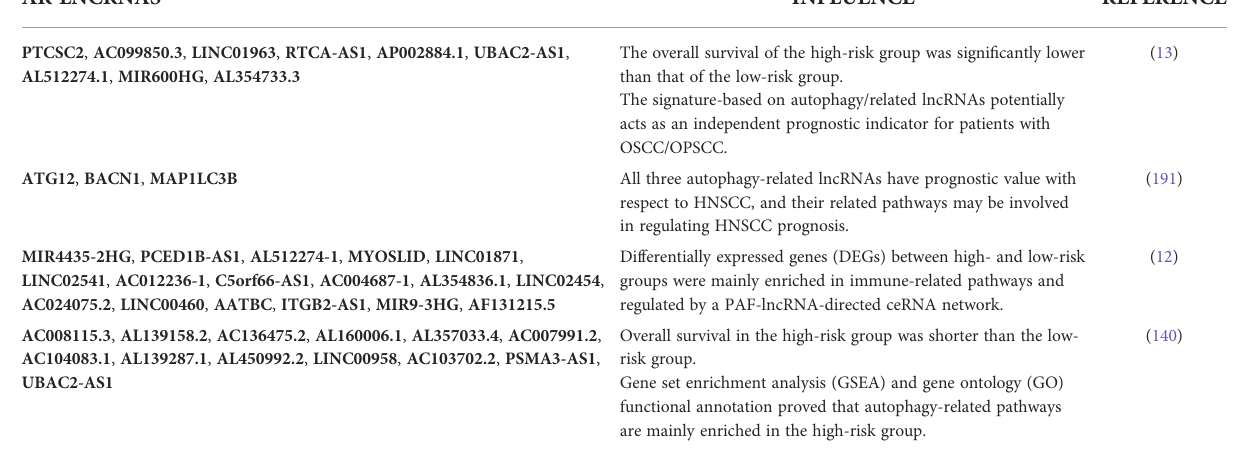
TABLE 3 Autophagy-related (AR) signatures of lncRNAs proposed as biomarkers in HNSCC. AR